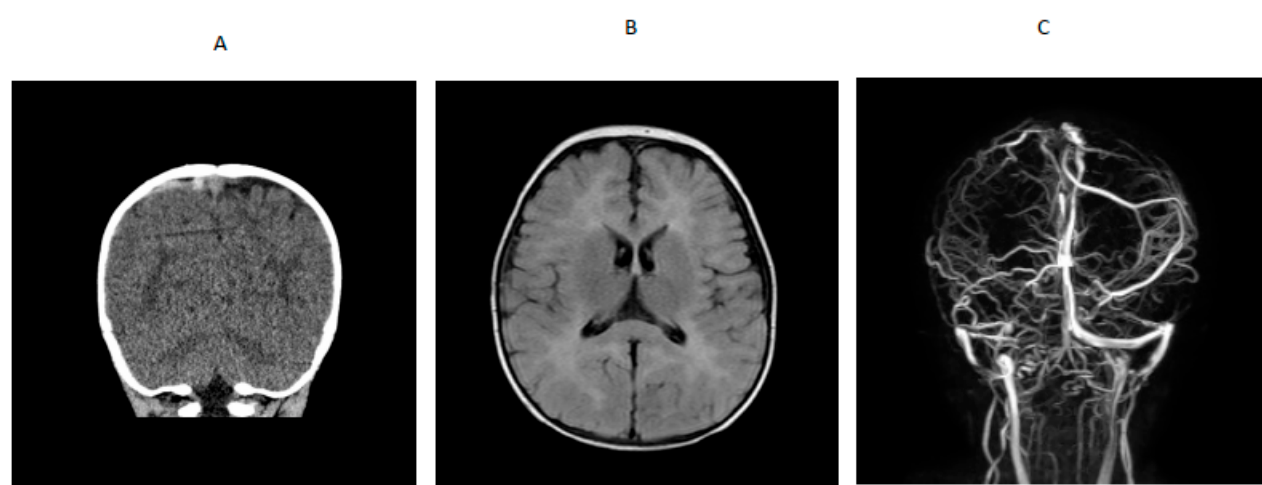
Figure 1. ( A ) CT scan showing venous hyperdense cortical vein over right parietal convexity. ( B ) MRI showing extensive white matter changes. ( C ) MRV showing thrombosis of right parietal cortical vein extending into the superior sagittal sinus.